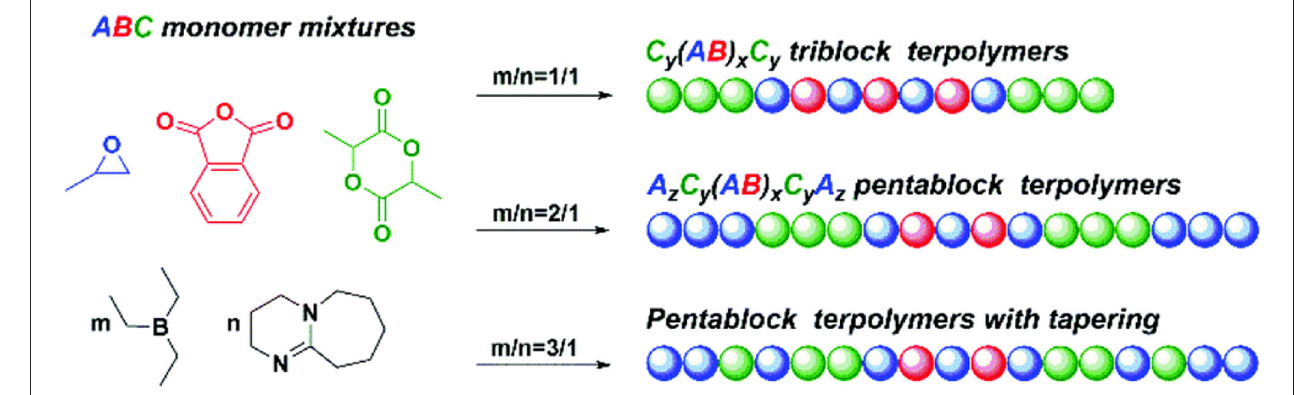
FIGURE 9 | TEB/DBU pair catalyzed highly selective terpolymerization of mixtures of PO, PA, and rac -LA. TEB, triethyl borane; DBU, 1,8-diazabicyclo[5.4.0]undec -7-ene; PO, propylene oxide; PA, phthalic anhydride; LA, Lewis acid. Adapted with permission from Zhu et al. (2020). Copyright 2020 The Royal Society of